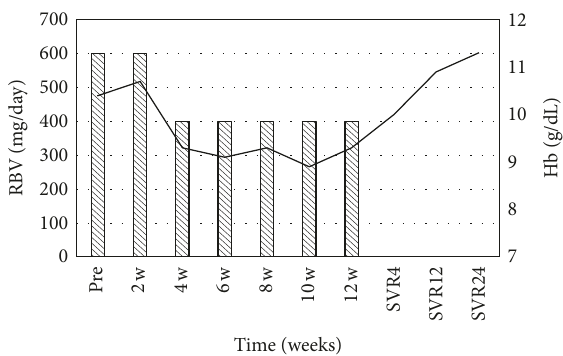
Figure 3: The variation of hemoglobin value with SOF and RBV combination therapy. Sofosbuvir dose was 400 mg/day.